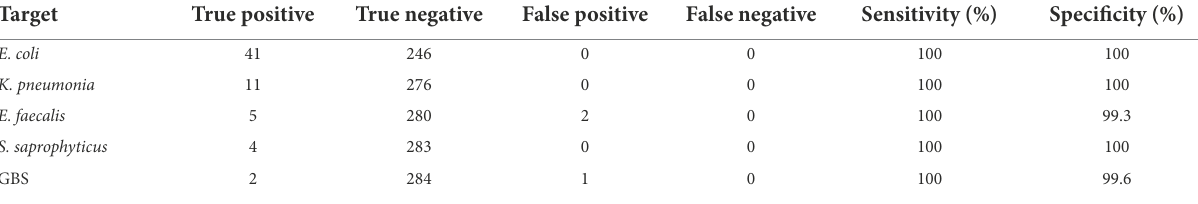
TABLE 3 Comparison of sensitivity and specificity of HRM assay versus culture identification method.